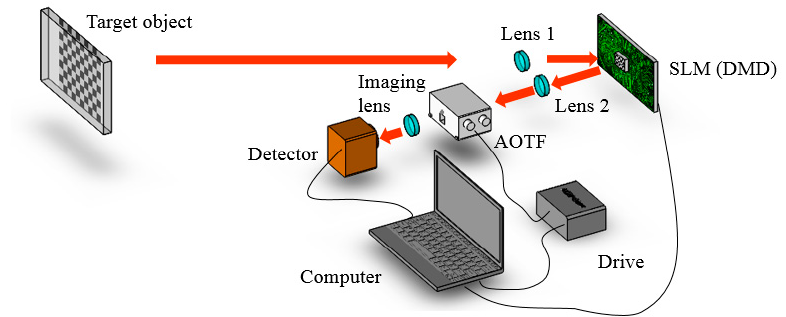
Figure 4. The setup of an AOTF imaging spectrometer based on single-pixel imaging (SPI). The focal length of the imaging lens was 8 mm. Lens 1 was focused on the digital micromirror device (DMD) and Lens 2 was the collimating lens. The DMD displayed the mask.